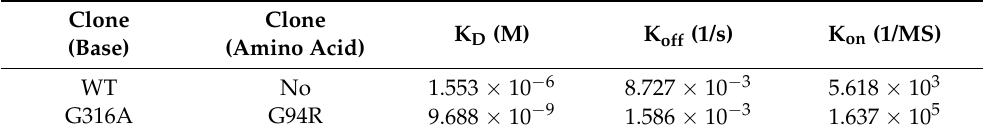
Table 1. Affinities of different mutations of anti TNFa scFv.